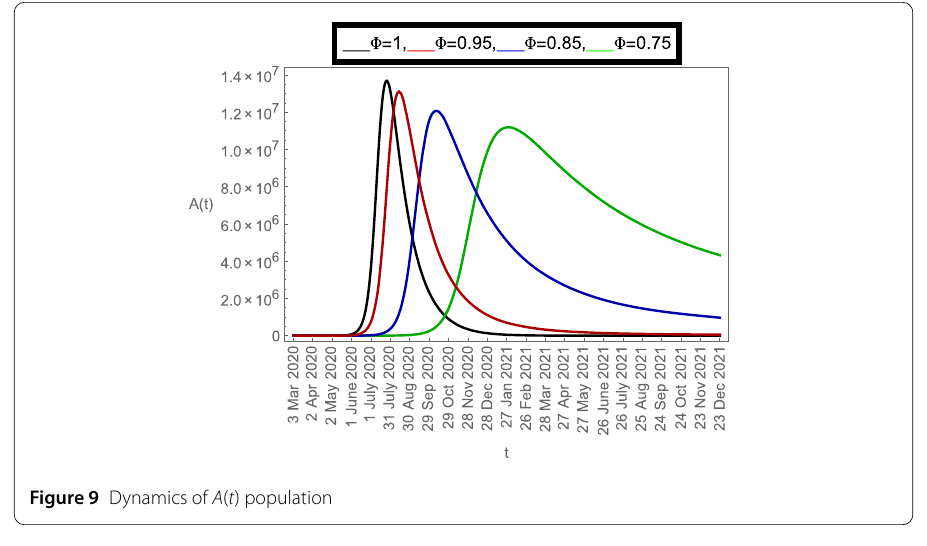
Figure 9 Dynamics of A ( t ) population